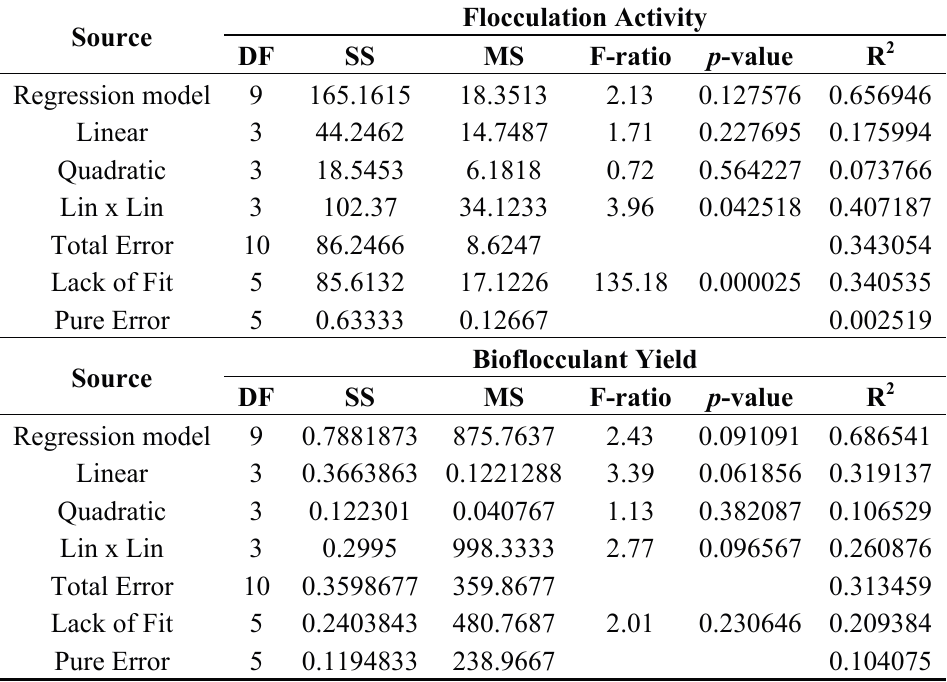
Table 5. Analysis of variance showing fitted quadratic polynomial model for optimization